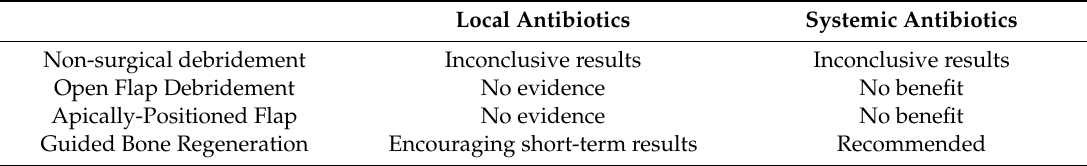
Table 2. Adjunctive use of local and systemic antibiotics in the treatment of peri-implantitis.